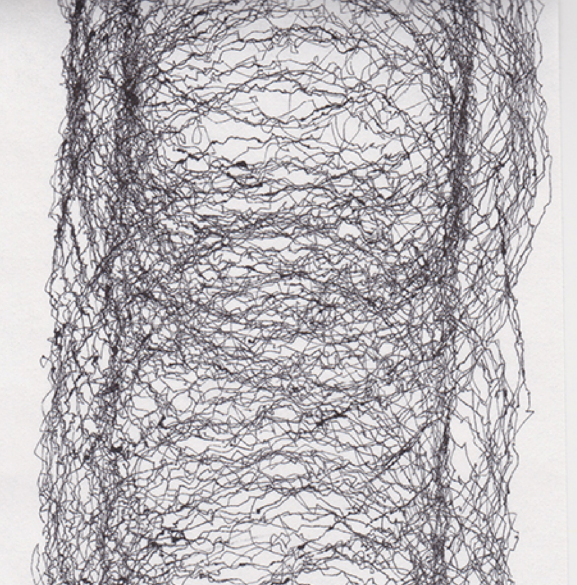
Figure 2 | Opener Drawing Nr. 1 (excerpt). An easily movable paper strip with a widely spaced spiral.